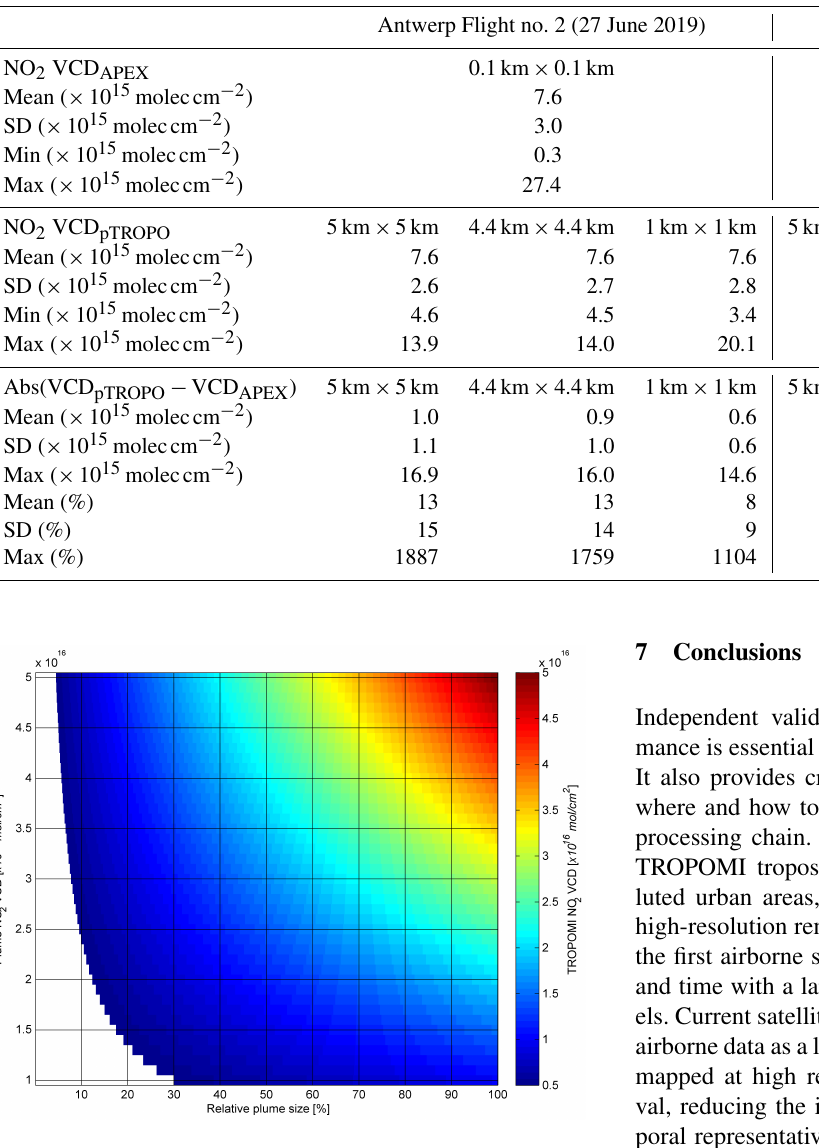
Figure 15. Simulations of NO 2 VCDs based on an iso- lated NO 2 hotspot surrounded by urban background pixels (3 × 10 15 moleccm − 2 ). The NO 2 hotspot is defined by its rela- tive size on the x axis, expressed as the fraction of a 3.5km by 5.5km TROPOMI nadir pixel, and average NO 2 signal strength on the y axis. The separation between the white area and syn- thetic NO 2 VCDs corresponds to the hotspot detection threshold of 5.1 × 10 15 moleccm − 2